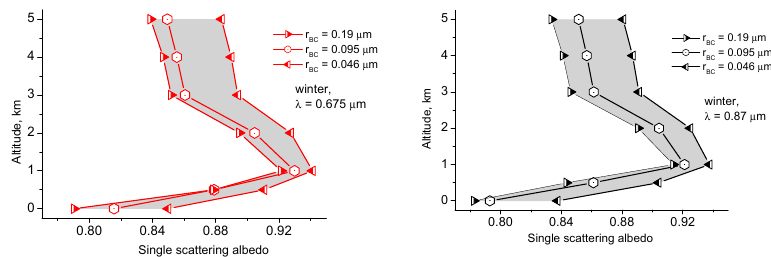
Figure 6. Vertical profiles of the single scattering albedo in summer and winter at different wavelengths at different median radii of the absorbing substance size distribution.